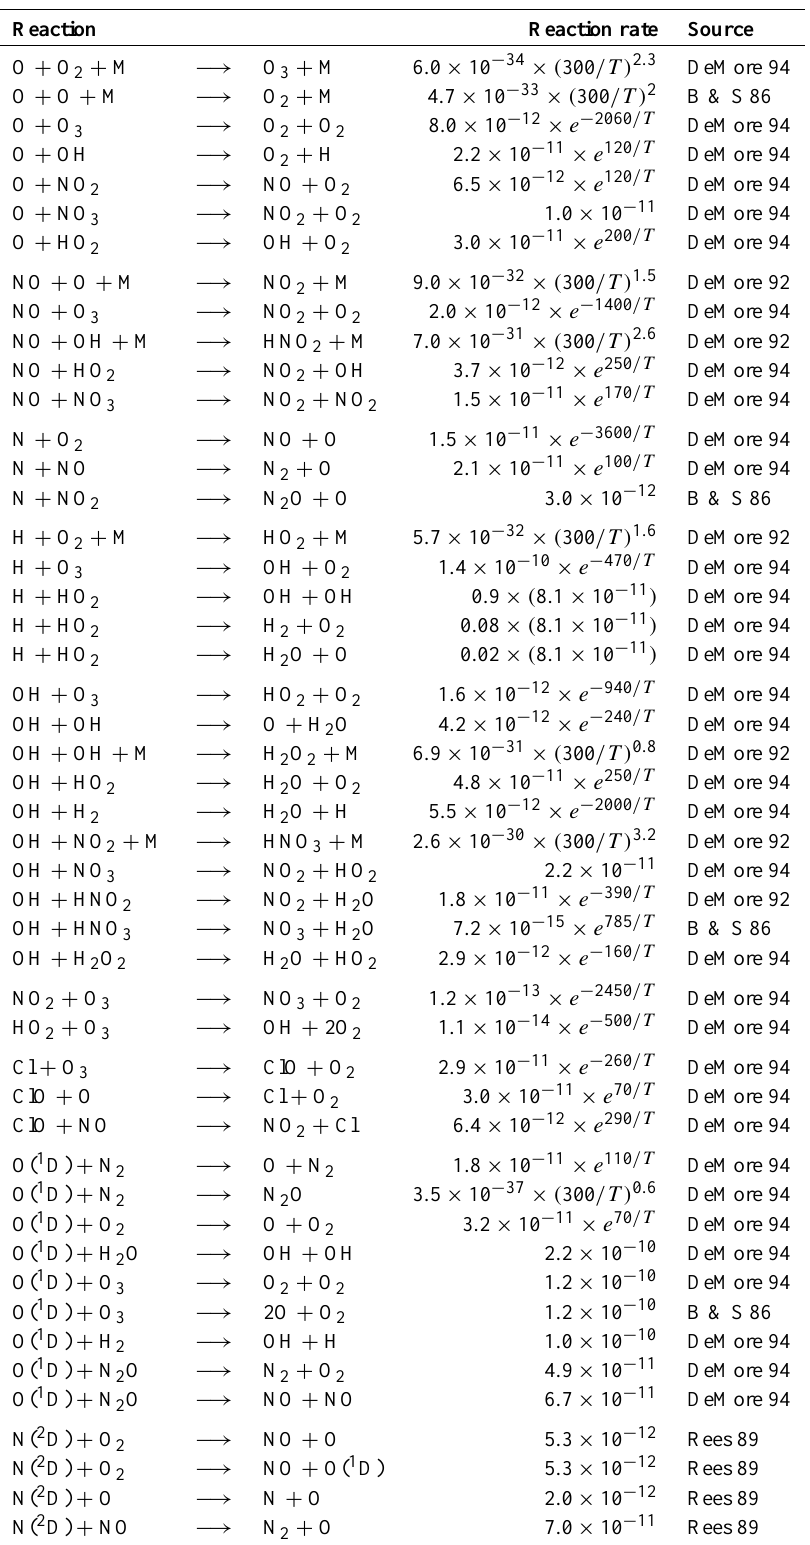
Table 1. A list of the neutral reactions that have been added to the SIC model. The sources for the reactions and rates are DeMore et al. (1994, 1992); Brasseur and Solomon (1986), and Rees (1989). Units are cm 3 s − 1 and cm 6 s − 1 for second and third order reactions, respectively. T is temperature and M is any atmospheric